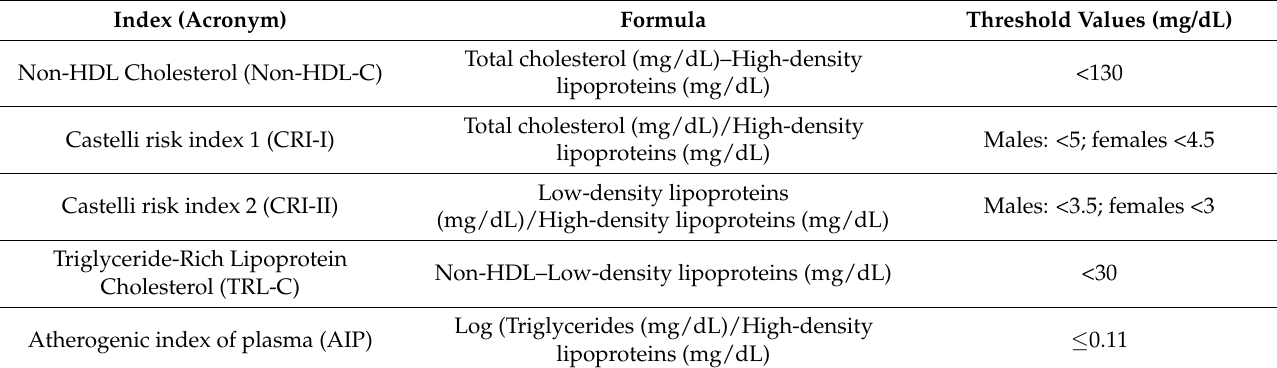
Table 2. Calculated lipid indices, their calculation, and suggested